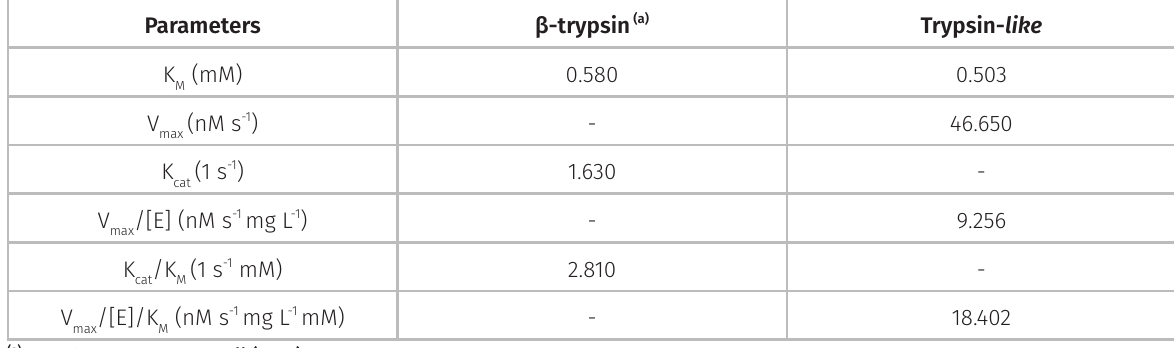
Figure 2. Michaelis-Menten graph for the hydrolysis of L-BApNA catalyzed by the enzyme. The substrate concentrations ranged from 0.1 mM to 1 mM. The points are experimental. Insertion: graph of the double reciprocal Lineweaver-Burk. The line drawn was calculated by linear regression with R 2 of